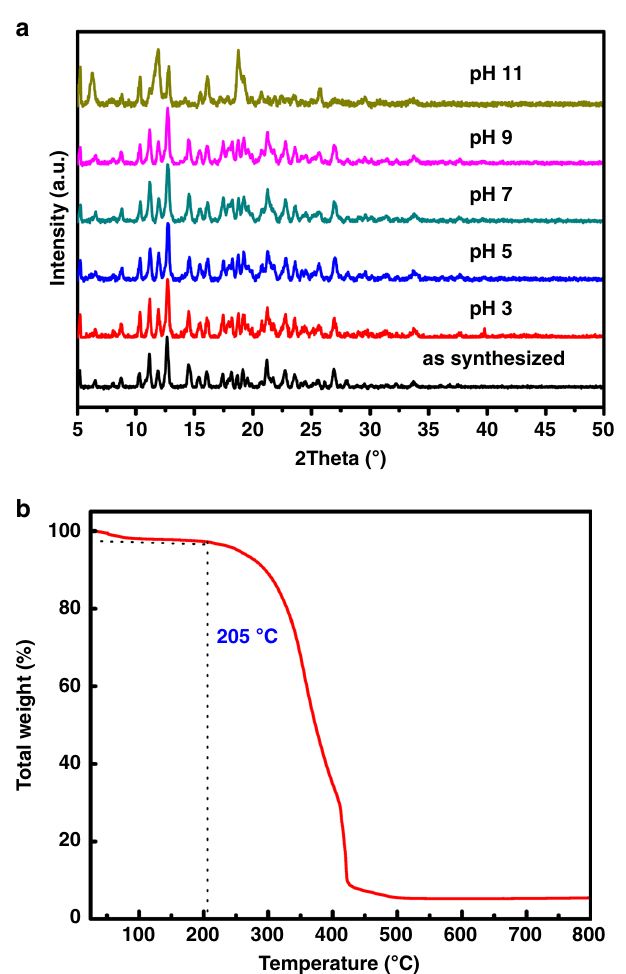
Fig. 3 Hydrolytic stability and thermal stability of SCP-IHEP-1. a PXRD patterns of SCP-IHEP-1 after soaking in aqueous solutions with varying pH values ranging from 3 to 11 for 12 hours at 298 K. b Thermogravimetric analysis (TGA) in air for